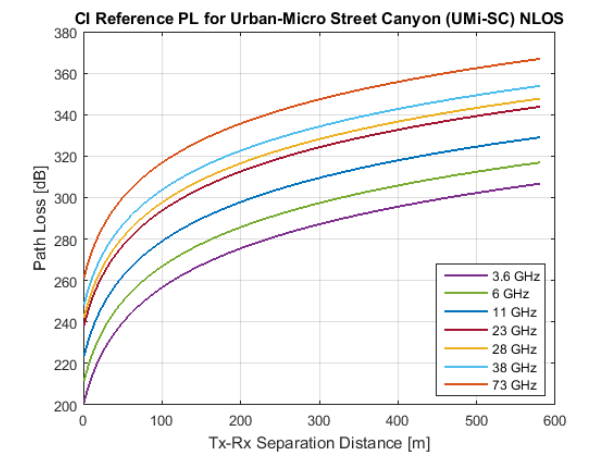
Fig 28. CI UMi-SC NLOS (600 m)